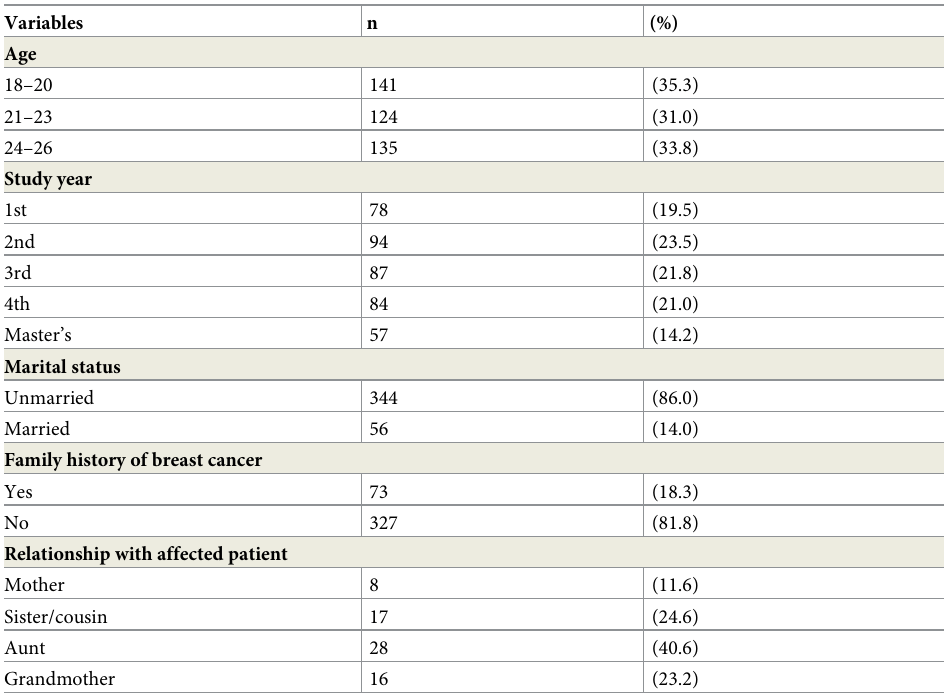
Table 1. Characteristics of